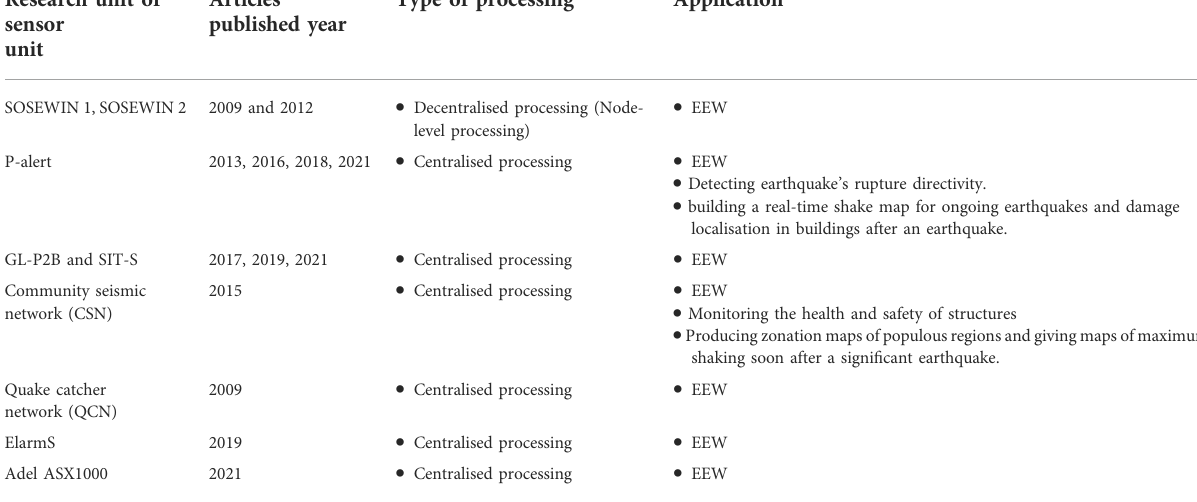
TABLE A1 An overview of the dedicated MEMS-based EEWSs according to their sensor unit or research unit, published year, type of processing and application. Research unit or